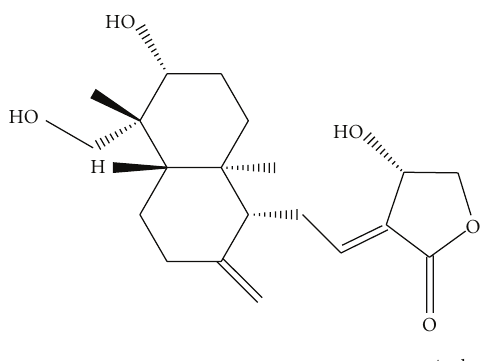
Figure 7: Structure of main constituents of Kalmegh ( Andrographis paniculata ) extracts (a)